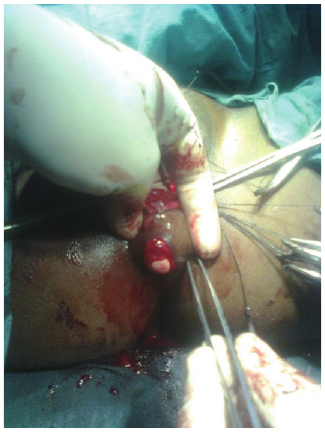
Figure 5: New anal opening